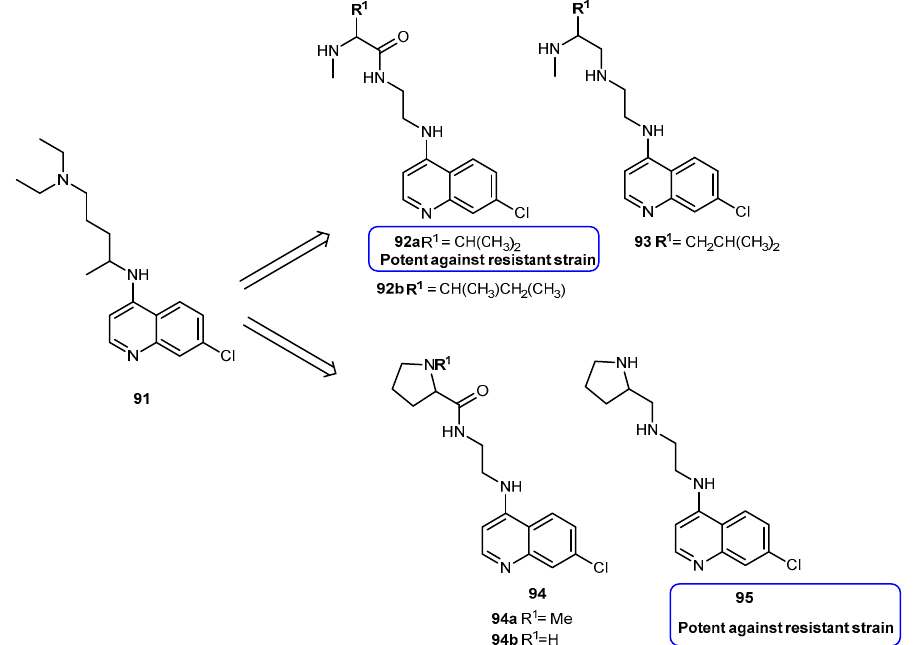
Figure 39. Chloroquine ( 91 ) and its side-chain modified 4-aminoquinoles ( 92 – 95 ). Derivative 95 was the most potent against resistant strain wheres 92a was the most potent against the sensitive strain.